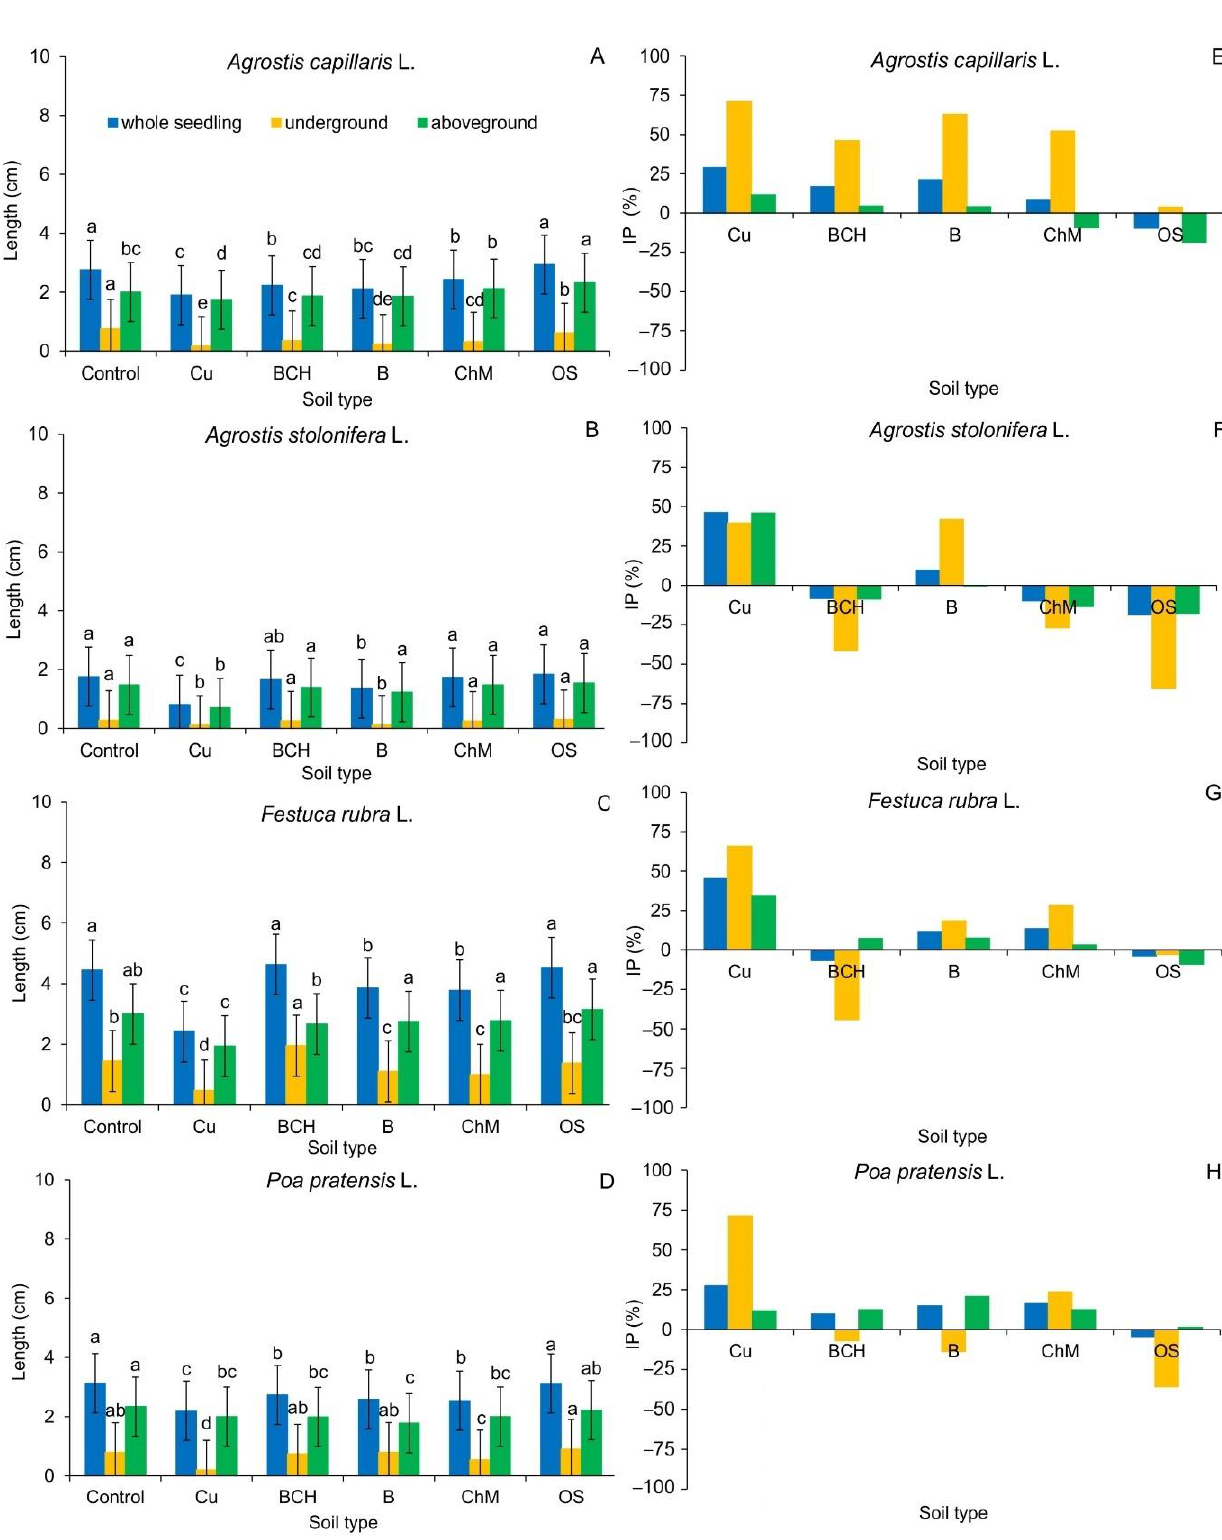
Figure 2. Length of grass seedlings germinated on various modifications of soil contaminated with copper; Cu—copper soil, copper soil with sorbents: BCH—biochar, B—bentonite, ChM—chicken manure, OS—organo-zeolitic substrate; mean values ( n = 5; ± SD) expressed in (cm): A – D and in % of control: E – H , marked with different letters (within each of the grass species) differ significantly according to Duncan's test with p ≤ 0.05.